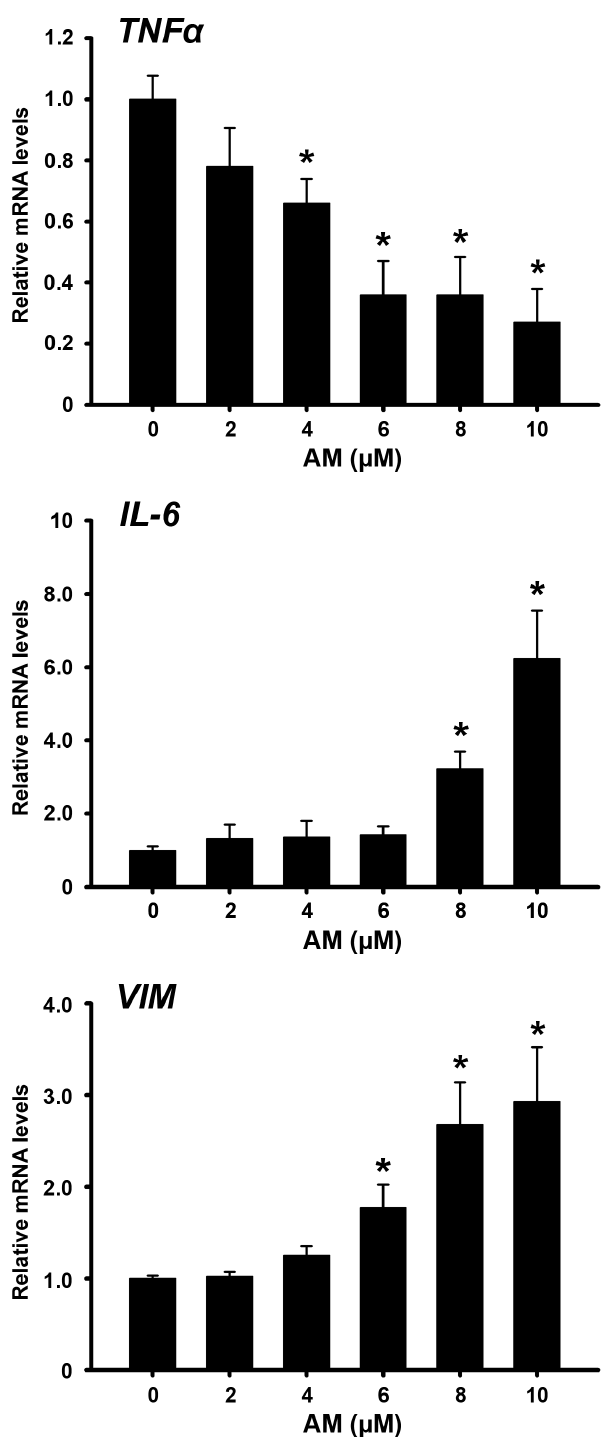
Figure 3. AM modulates cytokines and vimentin gene expression in CaSki cells. α -mangostin (AM) significantly differentially regulated tumor necrosis factor α ( TNF α ), interleukin-6 ( IL-6 ) and vimentin ( VIM ) gene expression. The results are the mean ± SEM of relative TNF α , IL-6, and VIM mRNA levels after normalizing against the housekeeping gene glyceraldehyde 3-phosphate dehydrogenase ( GAPDH ) mRNA expression. N ≥ 3 independent experiments. * p < 0.05 vs. vehicle-treated cells.